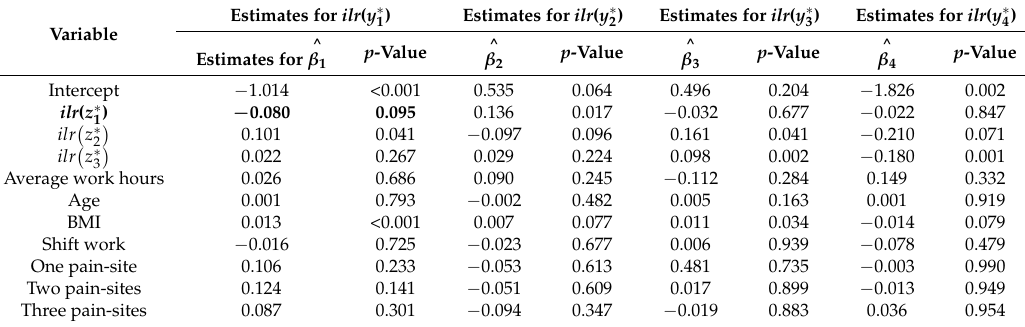
Table A2. Output for model 2b (among women, N =